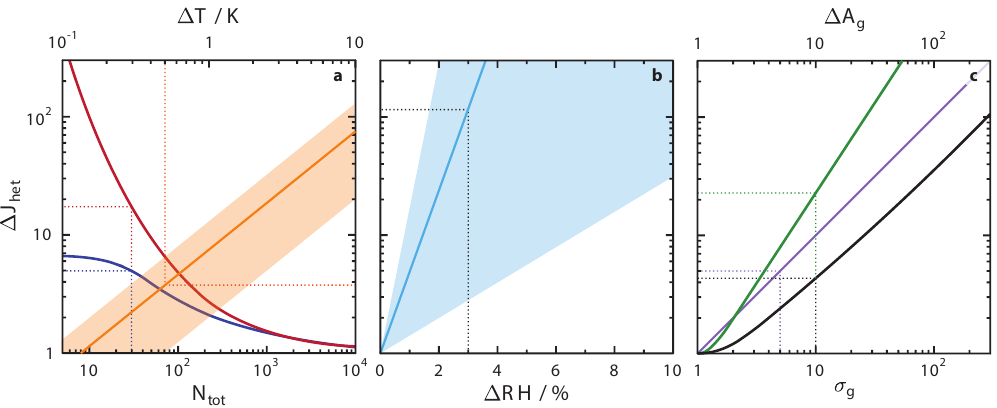
Figure 9. Uncertainty analysis derived from immersion freezing model simulations. The relative error in the experimentally derived hetero- geneous ice nucleation rate coefficient, J het , is referred to as (cid:49)J het . The y axis indicates (cid:49)J het as a factor error, e.g., (cid:49)J het = 10 indicates an error in J het by a factor of 10 in the positive and negative direction. Stochastic error due to the applied number of droplets, N tot , is shown in (a) where red and blue represent the upper and lower fiducial limits of J het , respectively. The error due to temperature accuracy, (cid:49)T , for a variety of INP types is shown in (a) in orange color where the solid line is average (cid:49)J het as a function of (cid:49)T and the shading is for a range of INP types. The error due to the absolute uncertainty in water activity or equivalently relative humidity, (cid:49) RH, is shown in (b) where the blue line is average (cid:49)J het , and the shading represents the range of values for a variety of INP types. The uncertainty due to variability in INP surface area, σ g , is shown in (c) as black and green lines evaluated at f frz = 0 . 1 and 0 . 9, respectively. The uncertainty in measuring absolute surface area, (cid:49)A g , is shown in (c) as the purple line. Further details and example uncertainty values given as dotted lines are described in the